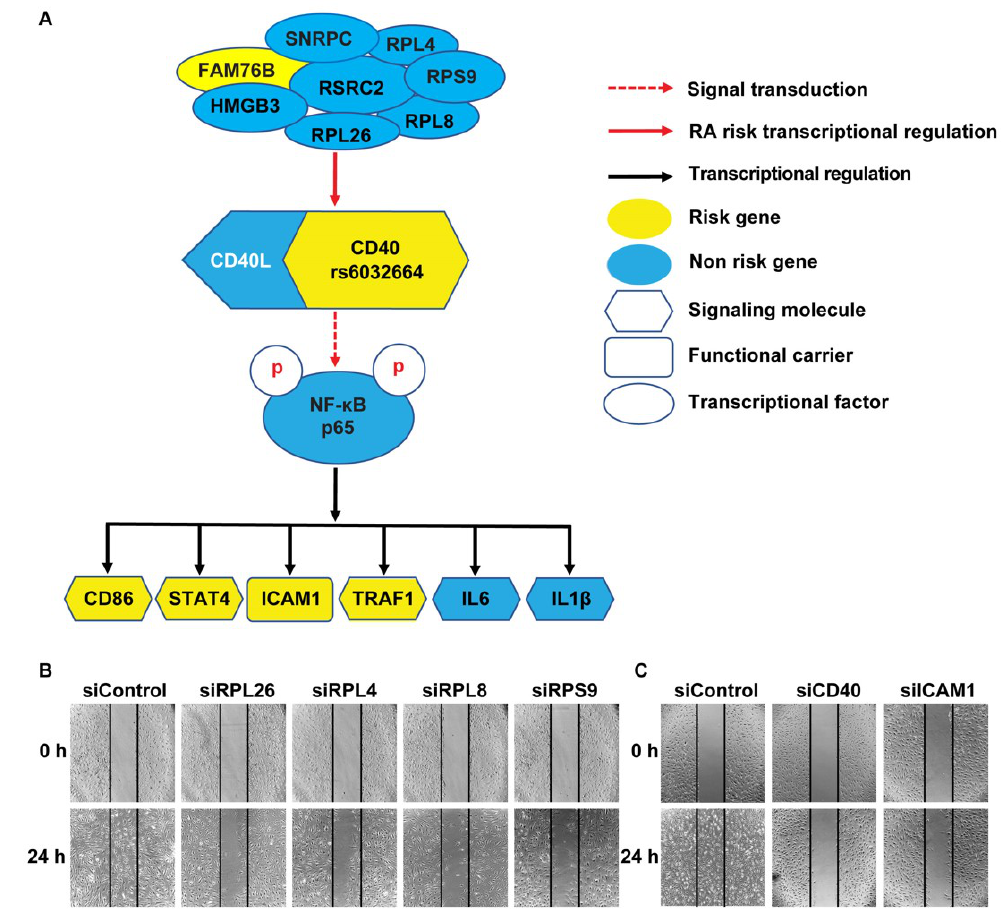
Figure 5. Disease-associated TRN linked by CD40-induced NF- κ B signal pathway. ( A ) scheme showing a disease-associated TRN linked by CD40-induced NF- κ B signal pathway. Eight proteins including RPL26, RPL4, RPL8, and RPS9 transcriptionally regulate CD40 expression via binding to fSNP rs6032664. Downstream of CD40-induced NF- κ B signaling, STAT4, TRAF1, ICAM1 , and CD86 as well as IL6 and IL1 β were regulated by NF- κ B p65 transcriptionally. FAM76B is a risk gene for MS. ( B ) Scratch-wound assay showing defects in cell migration in RPL26, RPL4, RPL8 , and RPS9 siRNA knockdown FLS. si: siRNA. ( C ) Scratch-wound assay showing defects in cell migration in FLS with CD40 and ICAM1 siRNA knockdown. Downregulation of CD40 and ICAM1 was demonstrated by Western blots as shown in Appendix A Figure